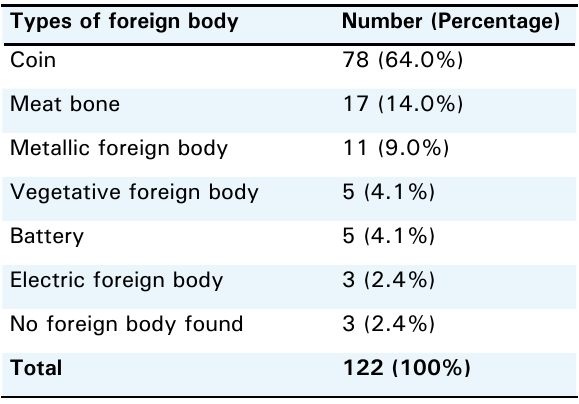
table 2.types of foreign